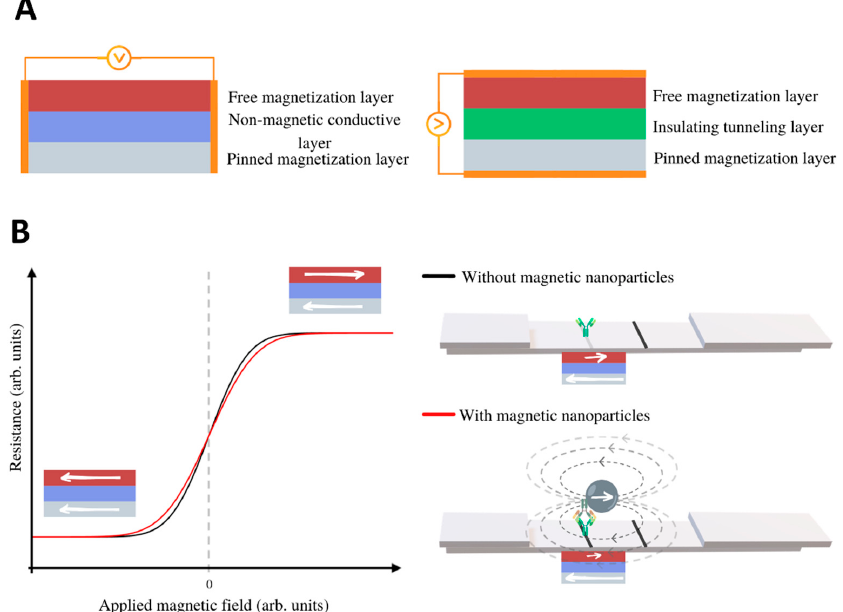
Figure 6. ( A ) Schemes of a Giant Magnetoresistance (GMR) sensor (left), and a Tunnel Magnetoresistance (TMR) sensor (right). ( B ) Scheme of the resistance of the MR sensor as a function of the applied field (black line). The MNP’s magnetic moments align in the direction of the applied field, and their solenoidal magnetostatic field reduces the magnetization of the free layer (the magnetic field lines are represented as grey dashed lines.) In consequence, if the applied field is positive, the resistance of the sensor decreases, and if it is negative, the resistance increases (red line).